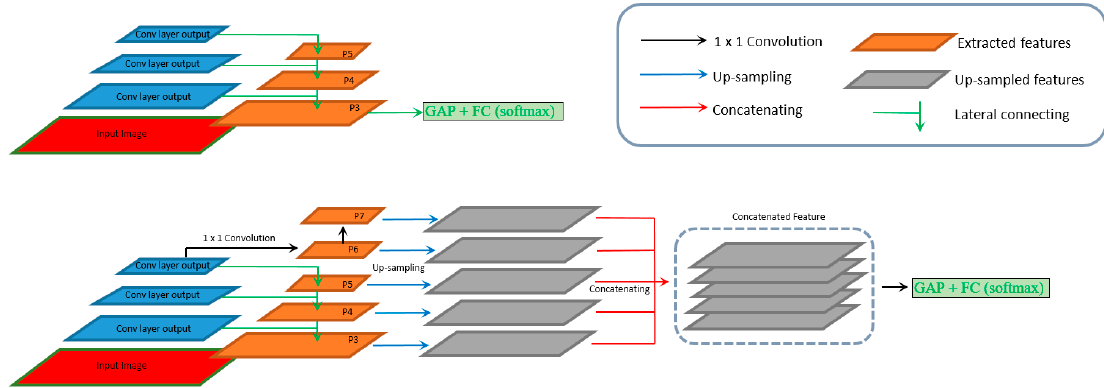
Figure 3. High-level architecture of the feature pyramid and our fine-tuned classification models with global average pooling (GAP) and fully connected (FC) layers. Top figure shows the architecture using one single pyramidal feature as the last convolutional layer, bottom figure shows the customized architecture using concatenated pyramidal features as the last convolutional layer. As each RetinaNet feature has 256 channel, the concatenated feature has 256 × N (feature number) channels. As shown in the 5 stacked gray feature blocks above, the concatenated features (P 3 , P 4 , P 5 , P 6 , and P 7 ) have 1280 channels.